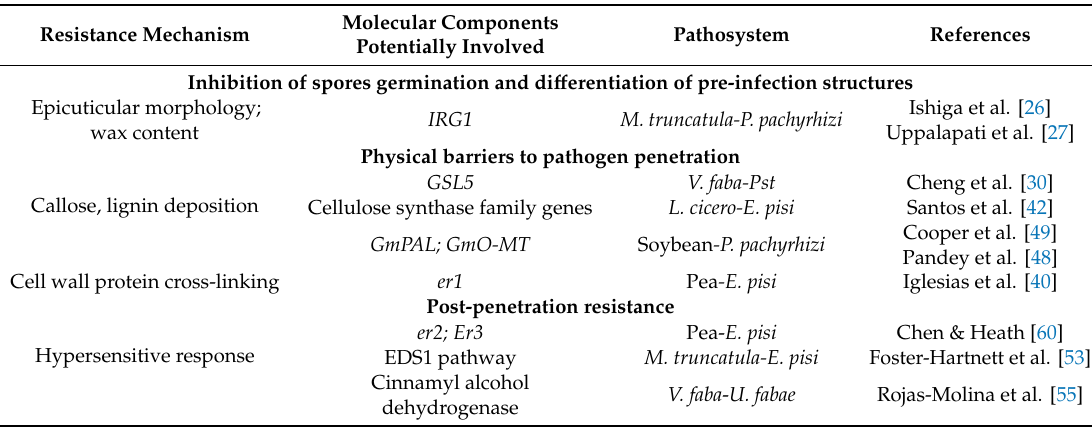
Table 2. A summary of the main resistance mechanisms discussed in this